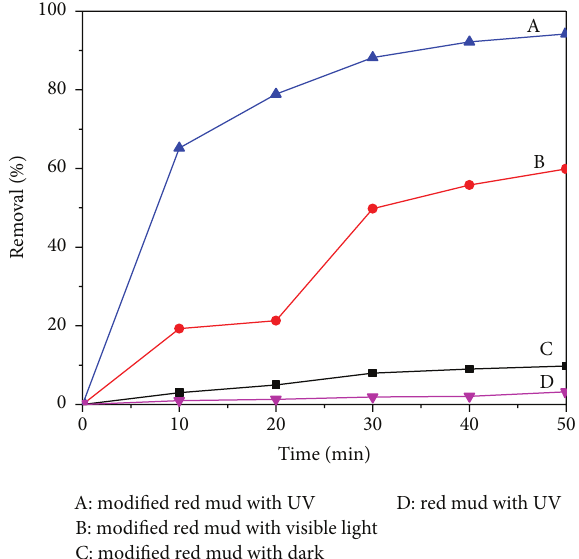
Figure 6: Comparison of degradation rate of MO under the different irradiation conditions.